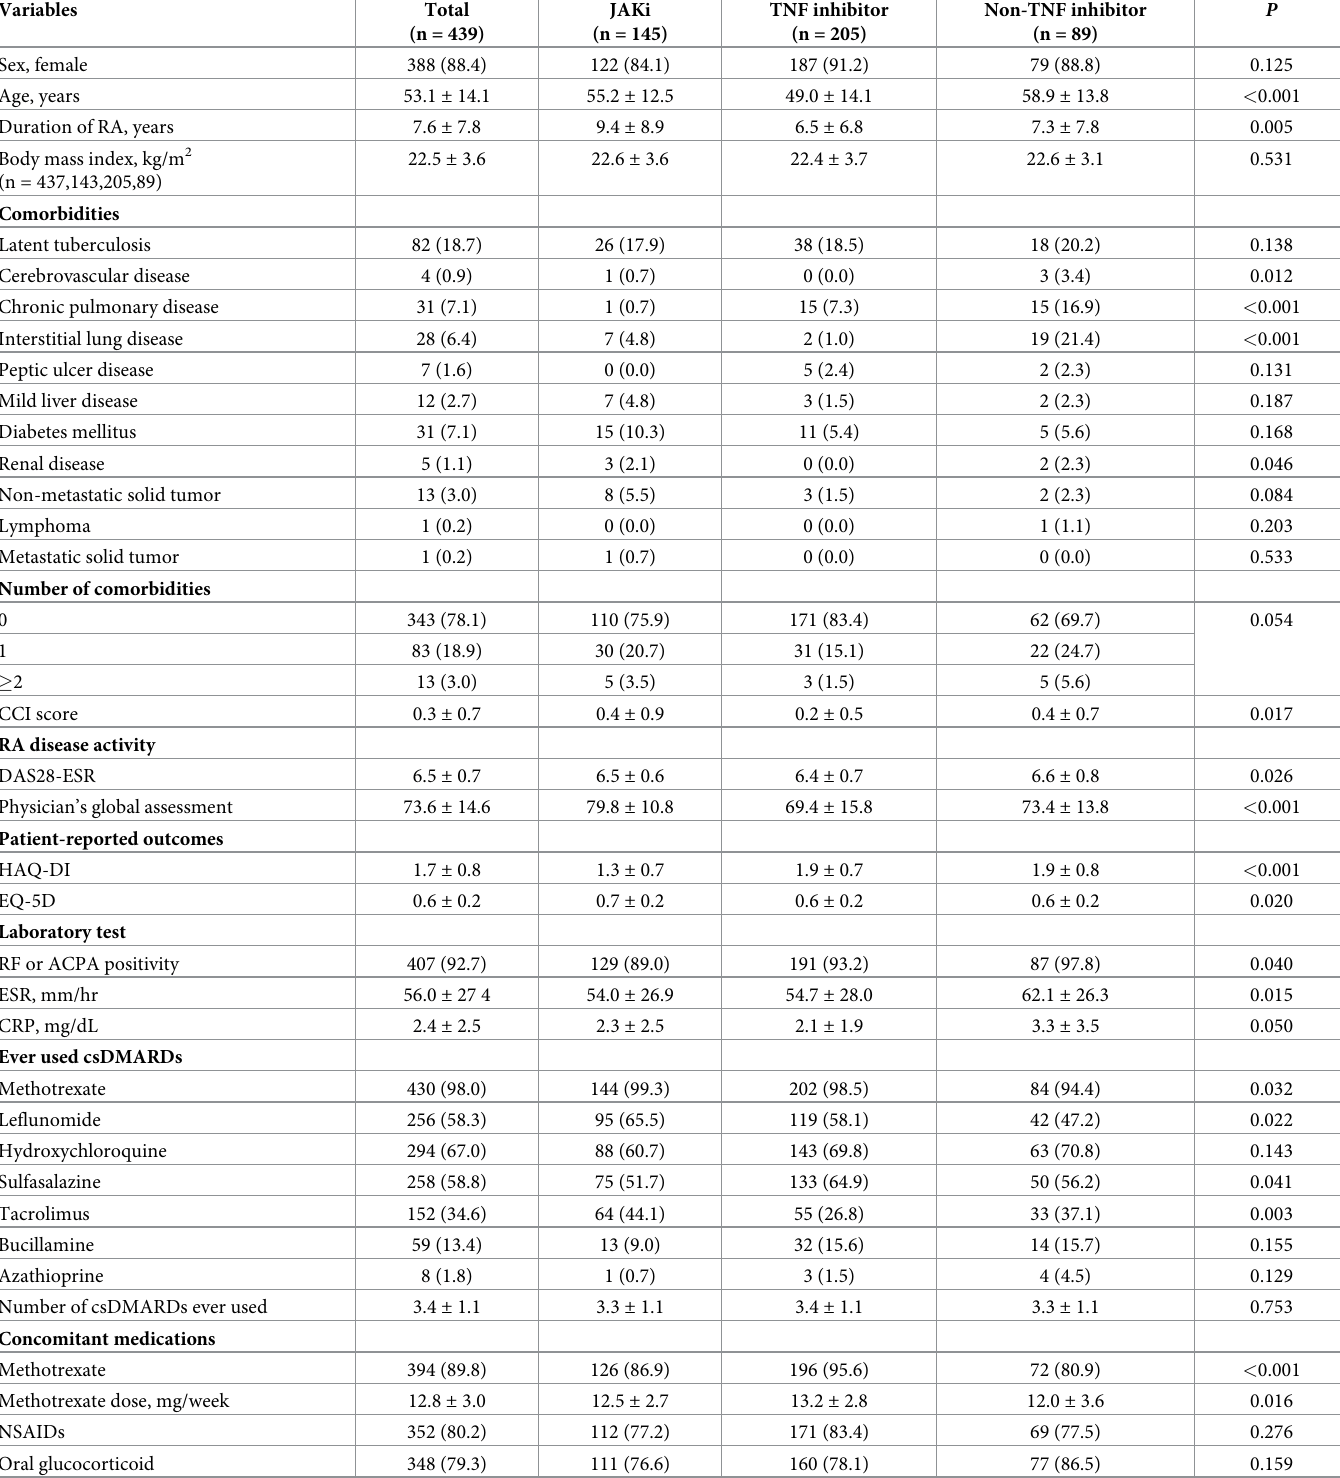
Table 1. Baseline characteristics of RA patients who initiated targeted